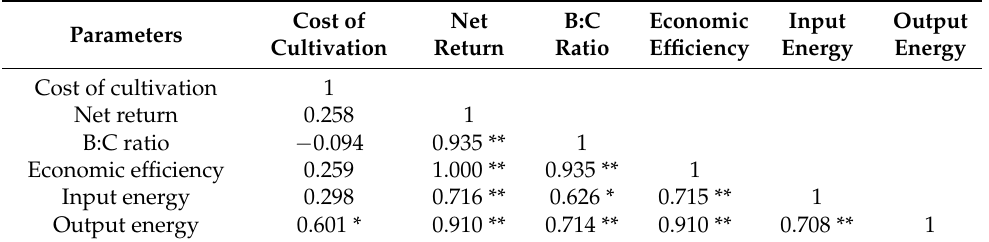
Table 9. Pearson’s correlation among % change from conventional management practices among different